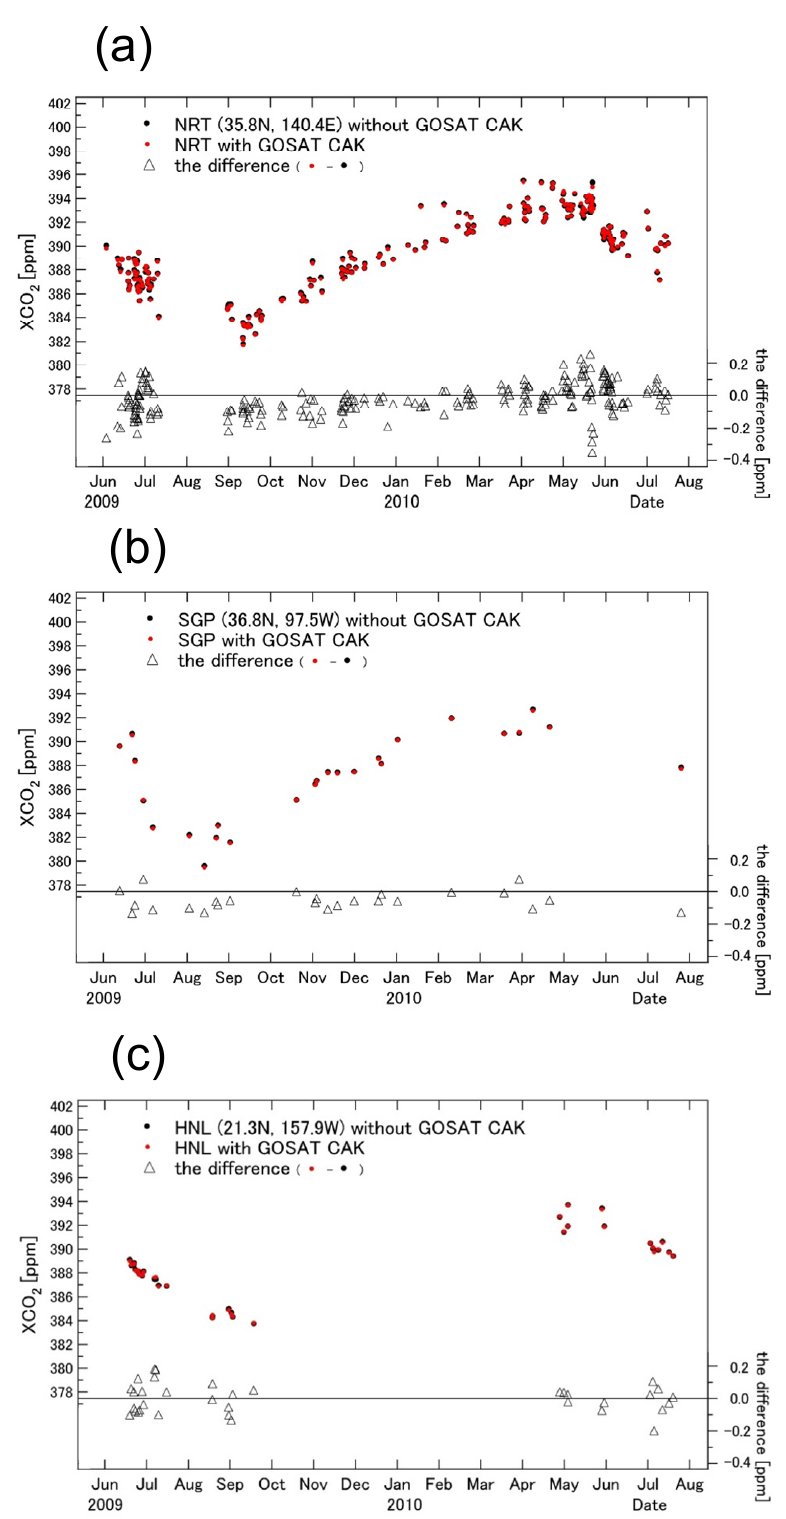
Fig. 4. Temporal variations of XCO 2 with and without CAK in (a) Narita, (b) the Southern Great Plains, and (c) Honolulu. Red and black closed circles indicate XCO 2 with and without the application of CAK, respectively. Open triangles denote the differences between XCO 2 with CAK and without CAK.